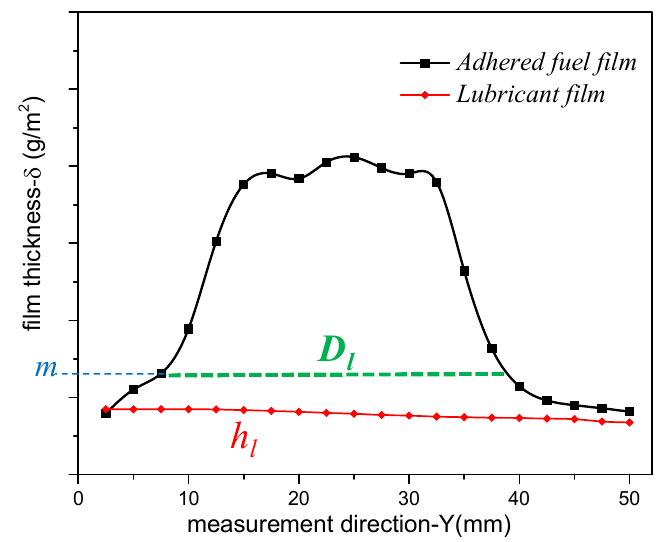
Figure 4. Thickness distribution of adhered fuel film represented by a longitudinal section profile in the middle of the film.